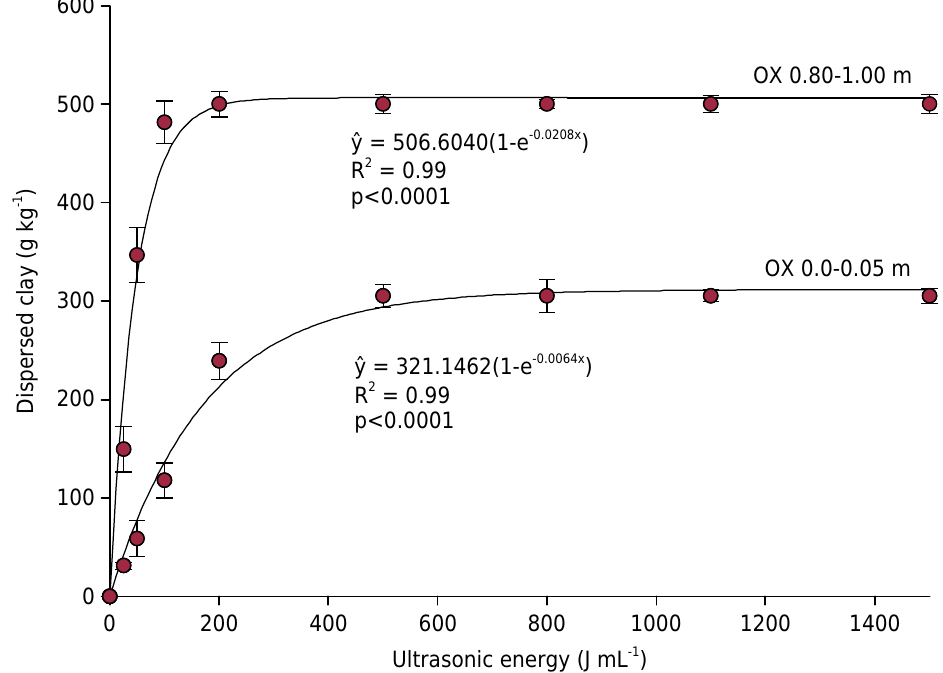
Figure 3. Ultrasound dispersion curves from two different samples of a Humic Hapludox under Araucaria moist forest.